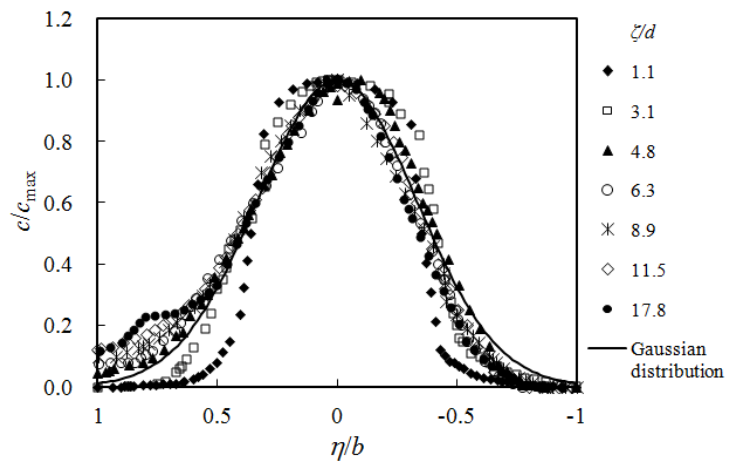
Figure 10. Radial concentration profile for the case on grid 1.